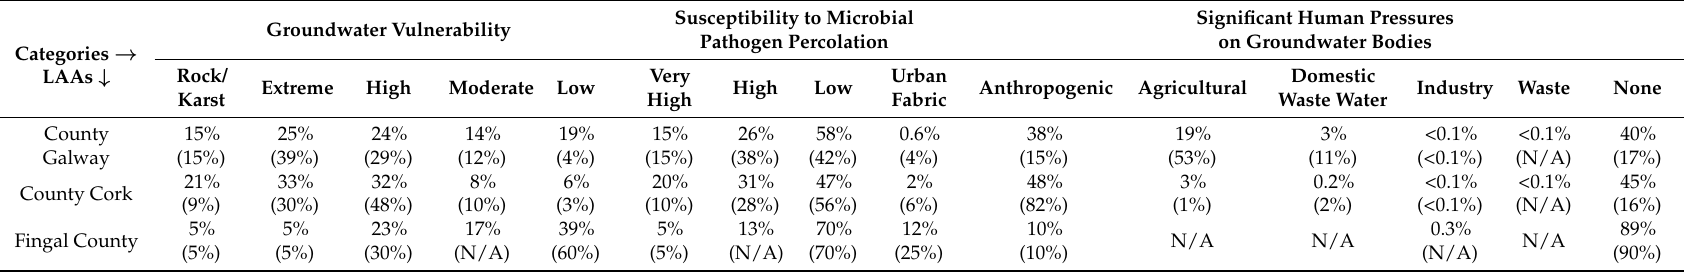
Table 4. Percentage area of groundwater bodies and boreholes under specific EPA NIP-WFD groundwater classifications and categories.